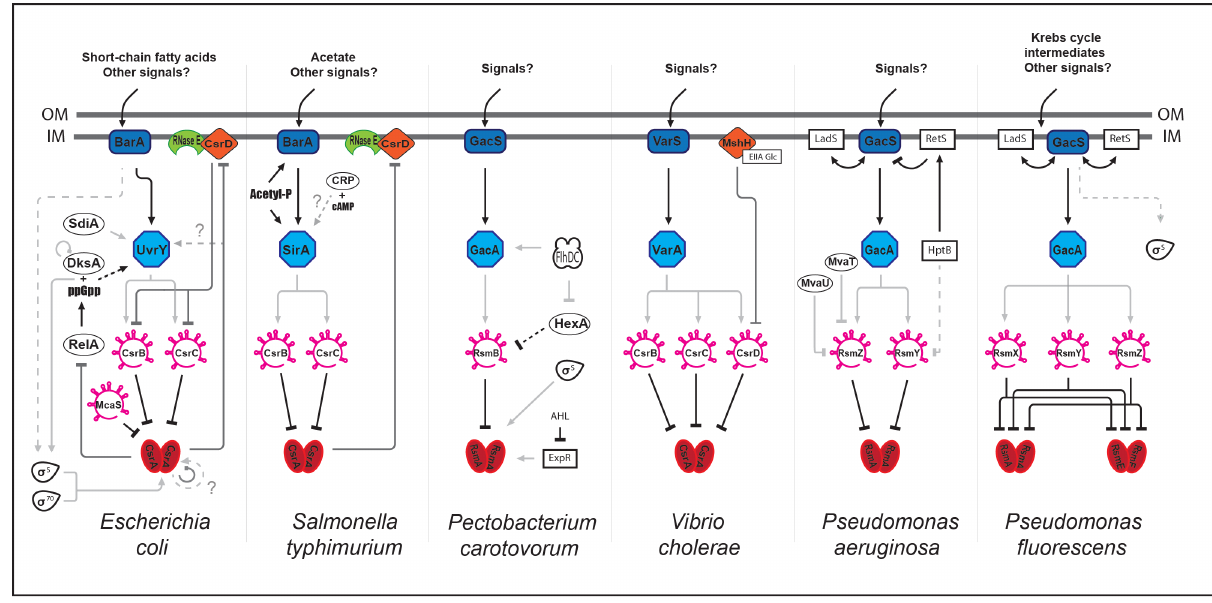
Figure 1. Interactions between the Csr network and global regulatory circuitries. Networks of Escherichia coli , Salmonella typhimurium , Pectobacterium carotovorum , Virbio cholerae , Pseudomonas aeruginosa , and Pseudomonas fluorescens are represented. The CsrA/RsmA/RsmE master regulator is negatively regulated by the Csr/Rsm-sRNAs, which are positively regulated by the BarA/UvrY TCS or its orthologues. Light grey, dark grey, and black lines represent transcriptional, post-transcriptional and post-translational regulations, respectively. Solid and dashed lines represent direct and indirect regulation, respectively. For details, see in the